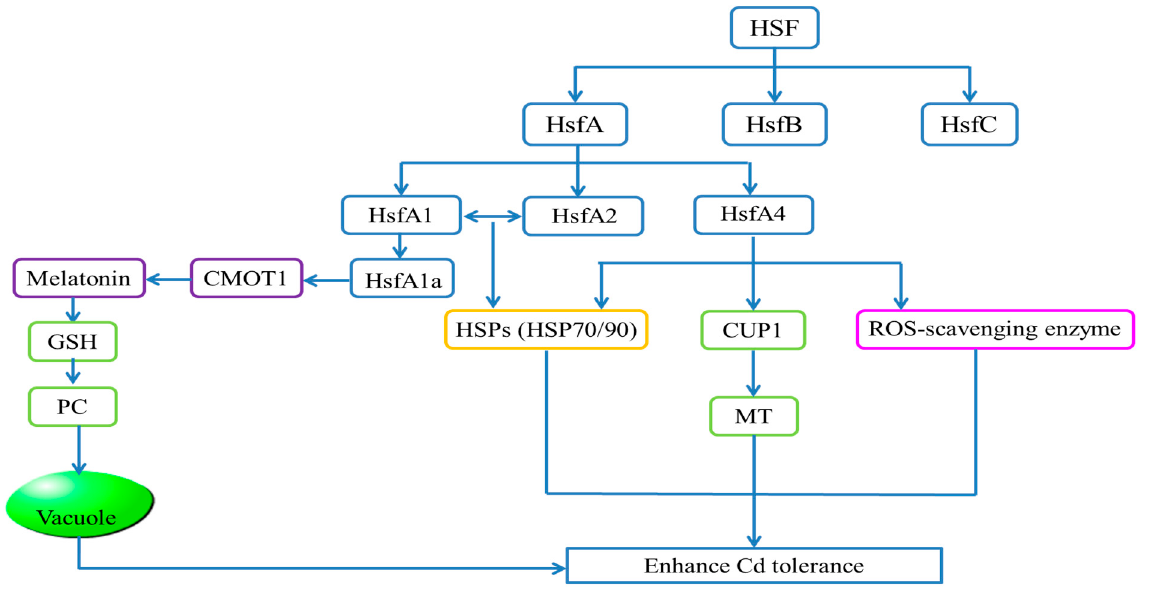
Figure 4. Transcriptional regulatory pathways of HSF TFs. HSFs are divided into three types: A, B, and C. HsfA plays a major role in enhancing Cd tolerance. HsfA1 interacts with HsfA2 to mediate the expression of HSPs such as HSP70 and HSP90. HsfA1a, as a kind of HsfA1, stimulates COMT1 gene expression and produces melatonin under Cd stress. Melatonin promotes the regulation of GSH and PC synthesis, causing Cd to enter the vacuole for sequestration. HsfA4 not only increases the expression of ROS-scavenging enzymes and HSPs, but also up-regulates the MT producing gene, CUP1 , to enhance Cd tolerance.